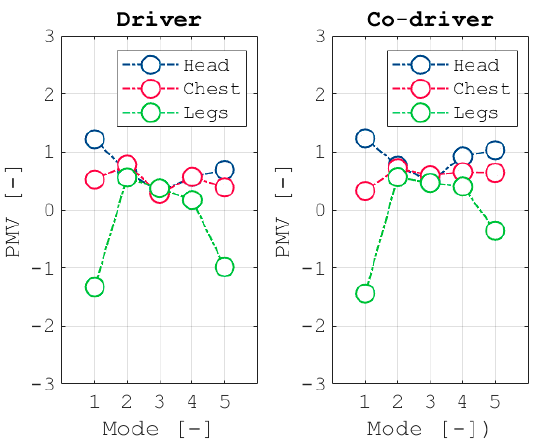
Figure 11. PMV value vs. HVAC mode: (left) driver; (right) co-driver. Figure 12. PMV value vs. the cabin temperature: ( left ) driver; ( right ) co-driver.